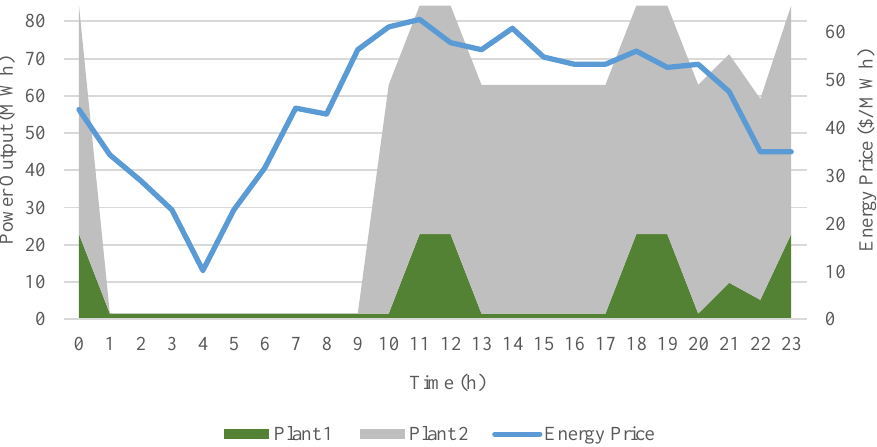
Figure 4. Energy Price Profile and Production Schedule of Plant 1 and 2 based on ANN-LSTM Method on 14 November.